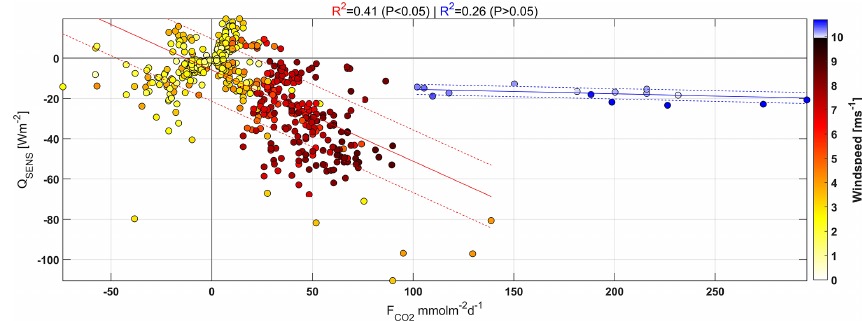
Figure 6. Correlations between sensible heat flux and CO 2 fluxes for the DNB site, color-coded according to wind